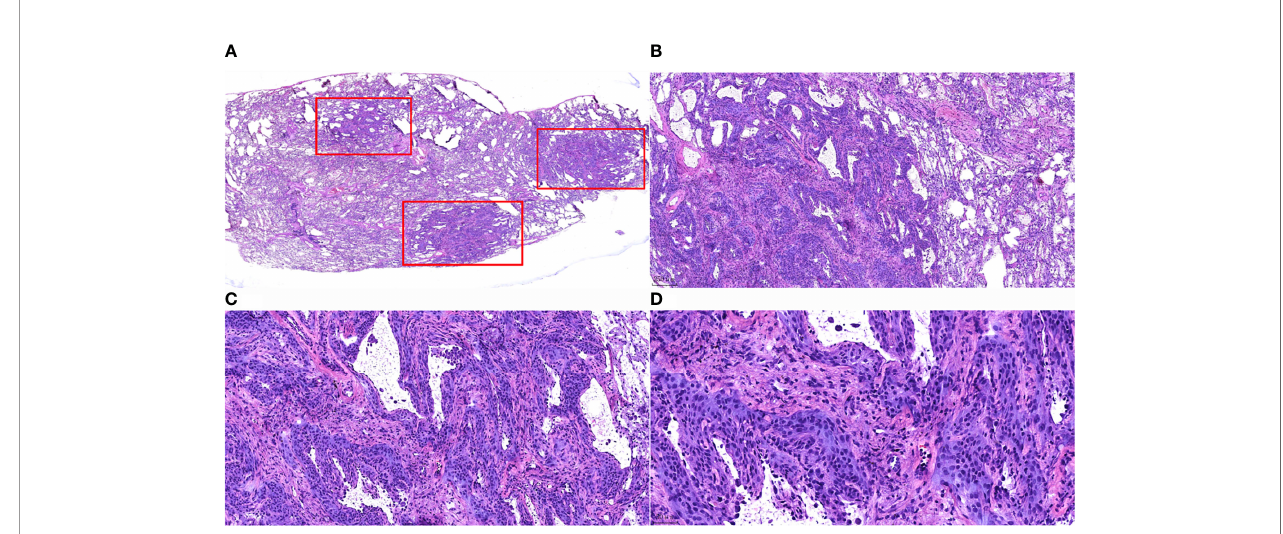
FIGURE 2 | Morphological characteristics of intraoperative frozen sections of MPMNs. (A) Frozen section HE staining x7.2. Three nodules (shown in the red box) with irregular morphology and clear borders are visible in the lung tissue. (B) x40 shows 1 of the nodules growing around the blood vessels. (C) Frozen section, HE staining, x100. The lesion cells are growing along the alveolar septum, with an open air cavity and the proliferation of interstitial fi brous tissue. (D) Frozen section, HE staining, x200. Well-differentiated cells were observed without atypia, with a smooth nuclear membrane, a low nucleo-cytoplasmic ratio and no pathological nuclear division. nested clusters of tumor cells, usually without alveolar lumen and residual alveolar epithelial cells. Bronchial adenomas are bilayered structures formed by epithelial cells and continuously arranged basal cells: the epithelial layer is structurally diverse and can be papillary or glandular luminal cells; the cell morphology may be consistent with mucous cells, alveolar epithelial cells, or